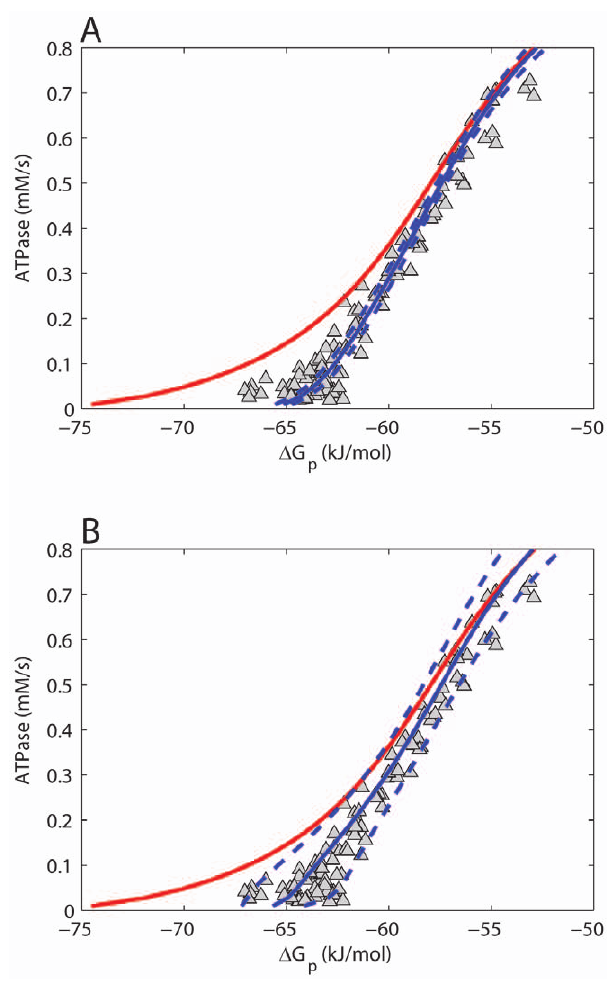
Figure 3. Model predictions of the n G p - J p relation. Model predictions of the relation between cellular phosphate potential ( n G p ) and mitochondrial ATP synthetic flux (ATPase) according to model configuration i (metabolic feedback regulation) ( A ), model configura- tion ii (regulation by parallel activation) ( B ). Model predictions are indicated as the mean (solid blue line) and STD (dotted blue line) of the 1000 simulations that were run in a Monte Carlo approach. Predictions of the original model are shown in red. Experimental data points are indicated by n . Data points were obtained from [14].